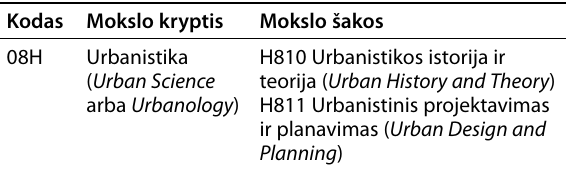
Kodas Mokslo kryptis Mokslo šakos H810 Urbanistikos istorija ir 08H Urbanistika teorija ( Urban History and Theory ) ( Urban Science H811 Urbanistinis projektavimas arba Urbanology ) ir planavimas ( Urban Design and Planning